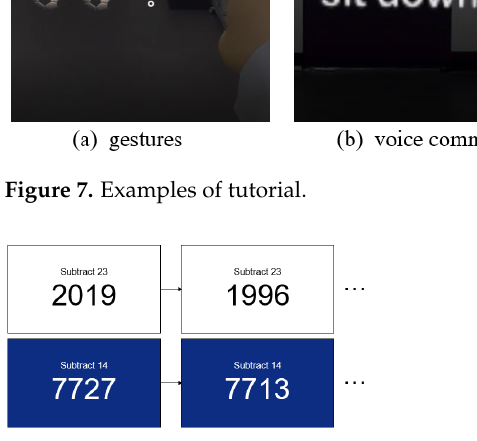
Figure 8. Examples of Mental Arithmetic